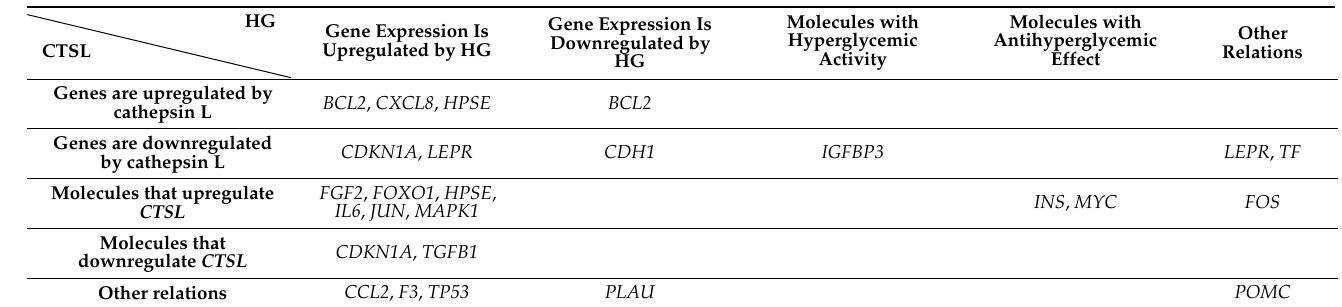
Table 8. Types of associations of the genes/proteins from hyperglycemia-related and cathepsin L (CTSL)-related networks with high glucose (HG) and cathepsin L ( STSL ).